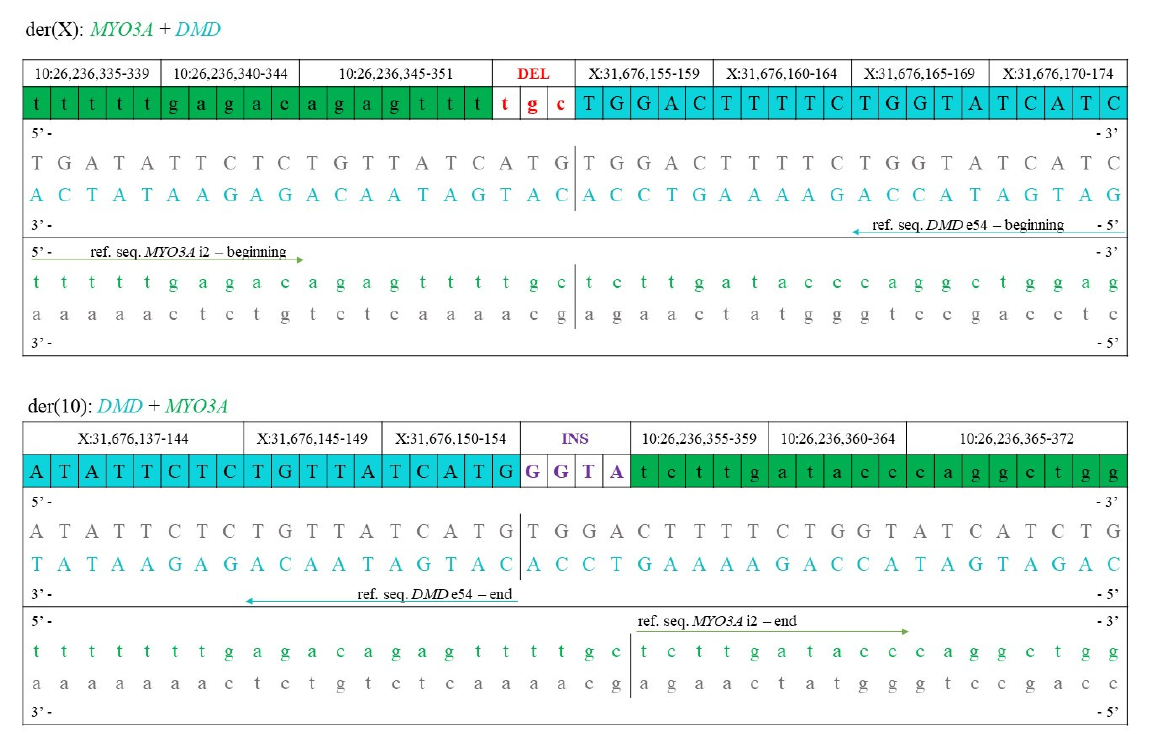
Figure 5. Sanger sequencing data showing the breakpoints (generated by Chromas 2.6.6), confirming that there is a 3bp (TGC) deletion on the der(X) chromosome and a 4bp (GGTA) insertion (indicated by the yellow box) on the der(10) chromosome.